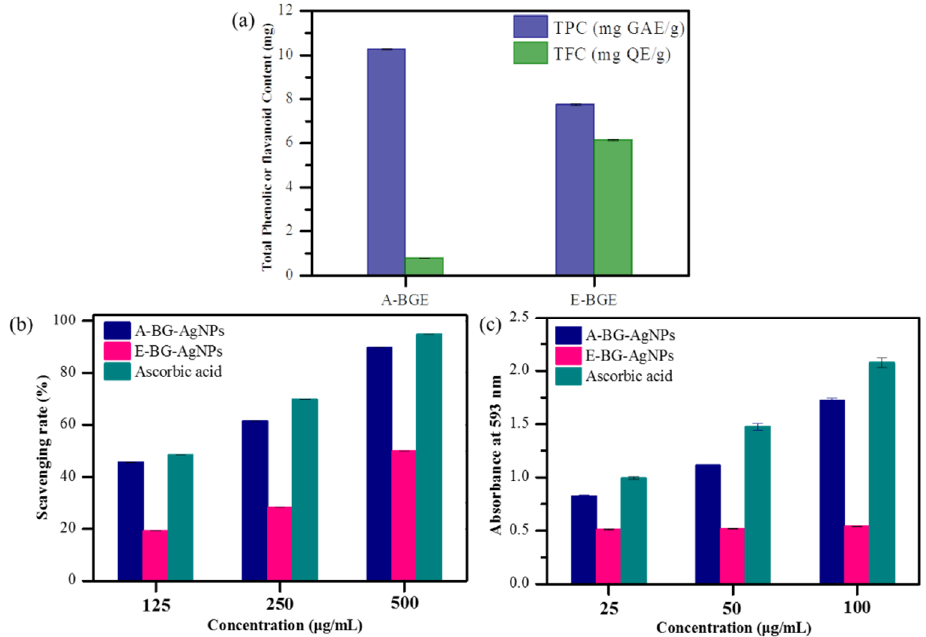
Figure 7. ( a ) Total phenolic and flavonoid content analysis of the BG extracts. ( b ) DPPH radical scavenging activity and ( c ) ferric-reducing ability assays of the BG-AgNPs and ascorbic acid. Each test was performed in triplicate and repeated three times individually.